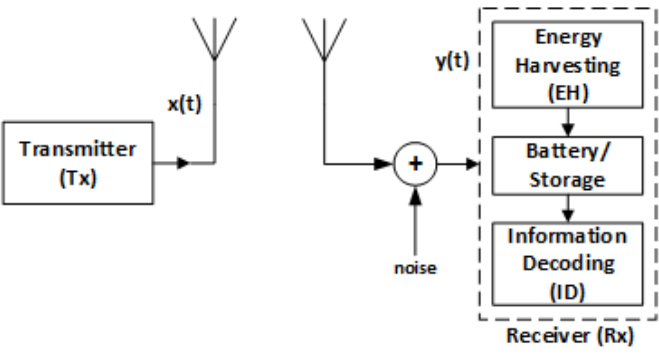
Figure 1. Simultaneous wireless information and power transfer (SWIPT) model.